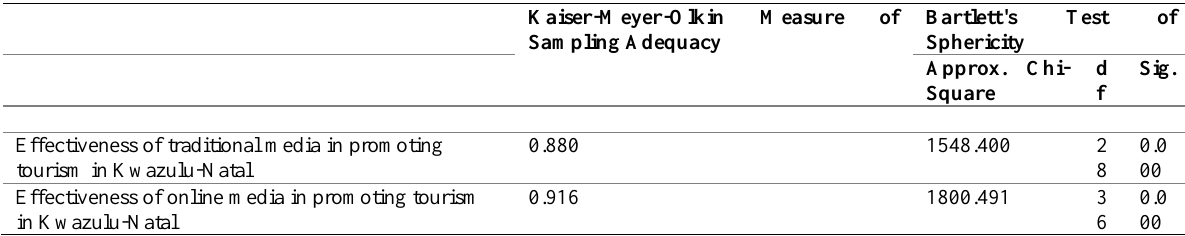
Table 2: KMO and Bartlett's Test